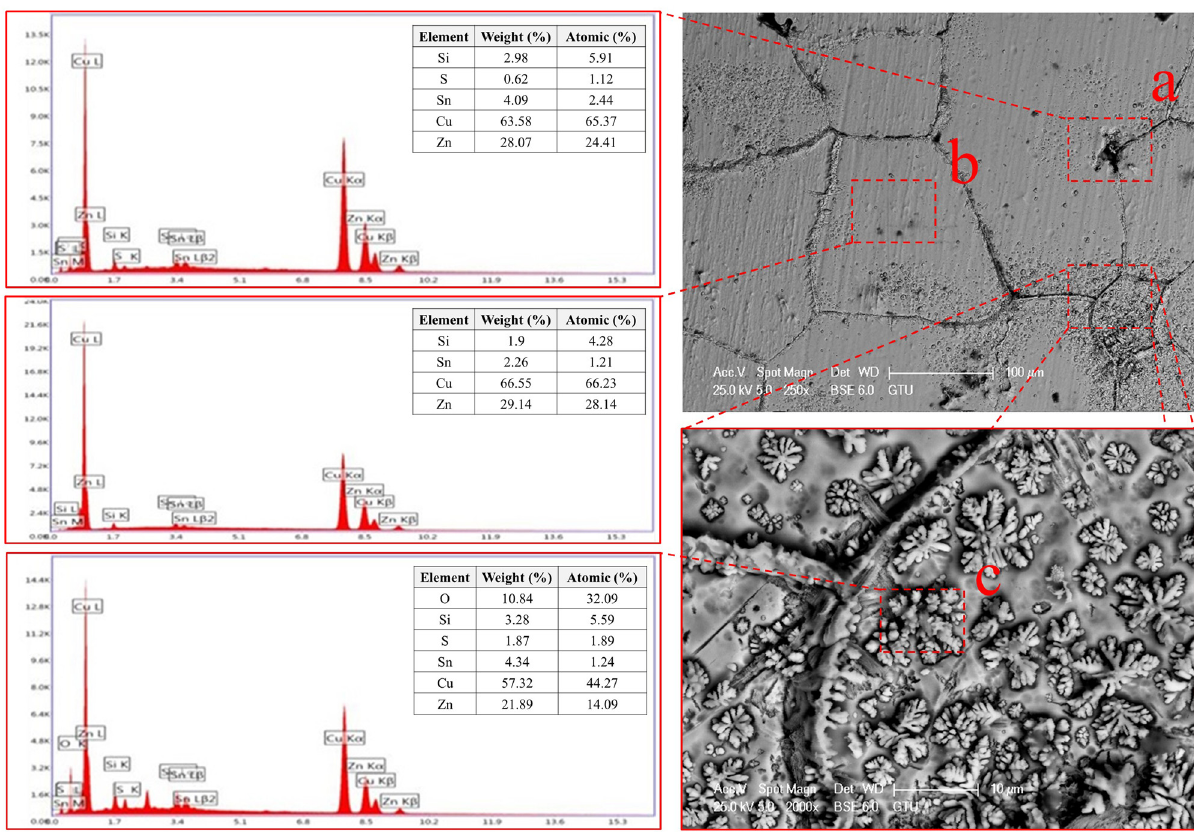
Figure 6: The results of EDS analysis from regions labeled ( a – c ) in the SEM image of MoS 2 -